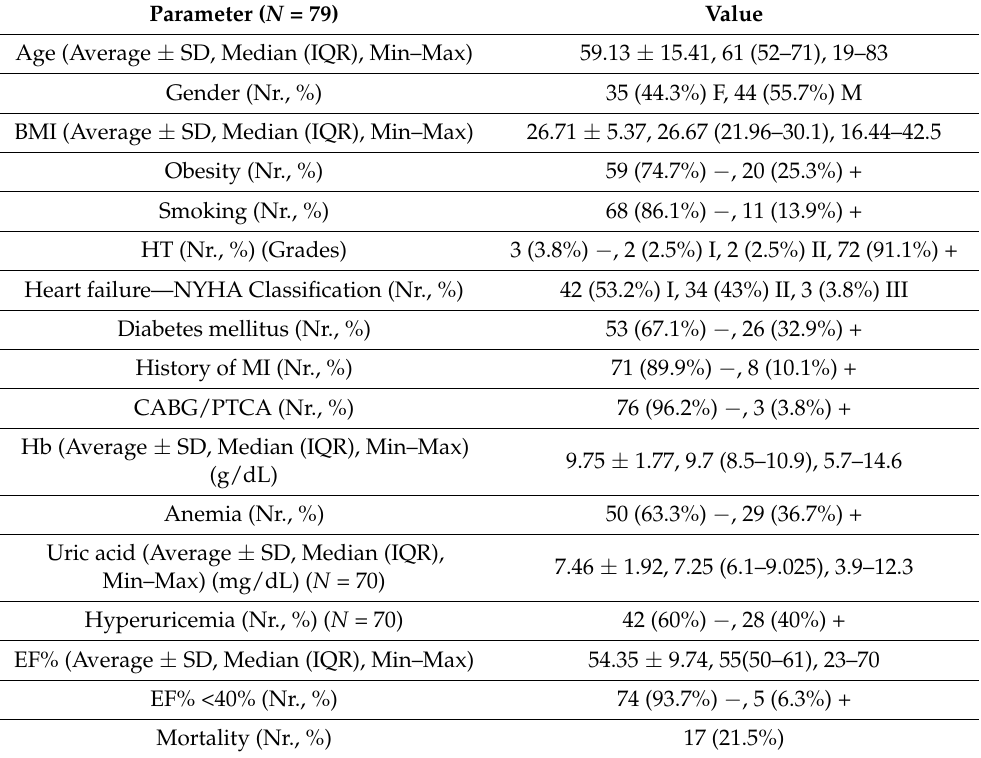
Table 1. Characteristics of the analyzed